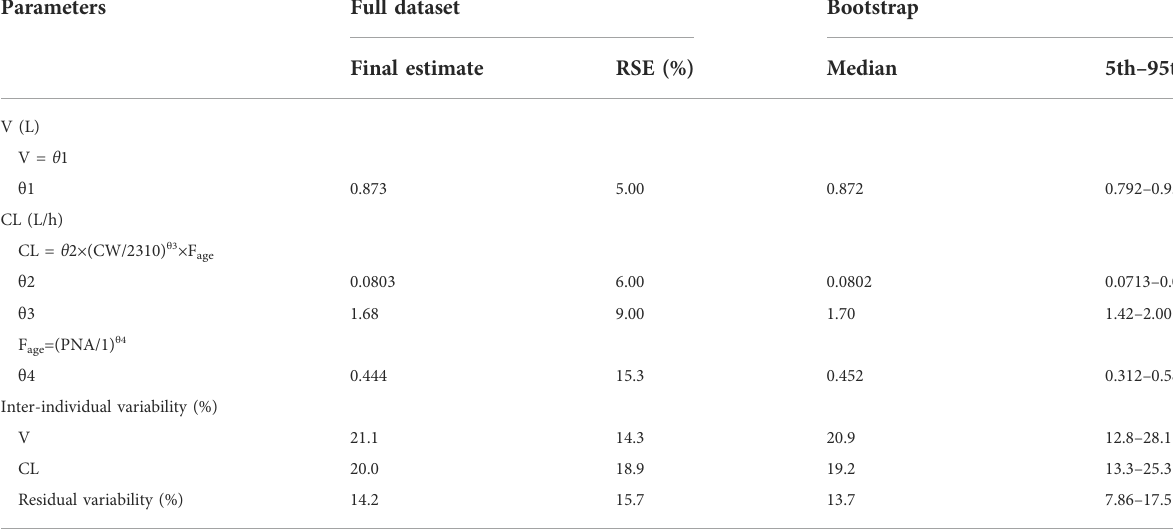
TABLE 2 Population pharmacokinetic parameters of cefotaxime and bootstrap results.